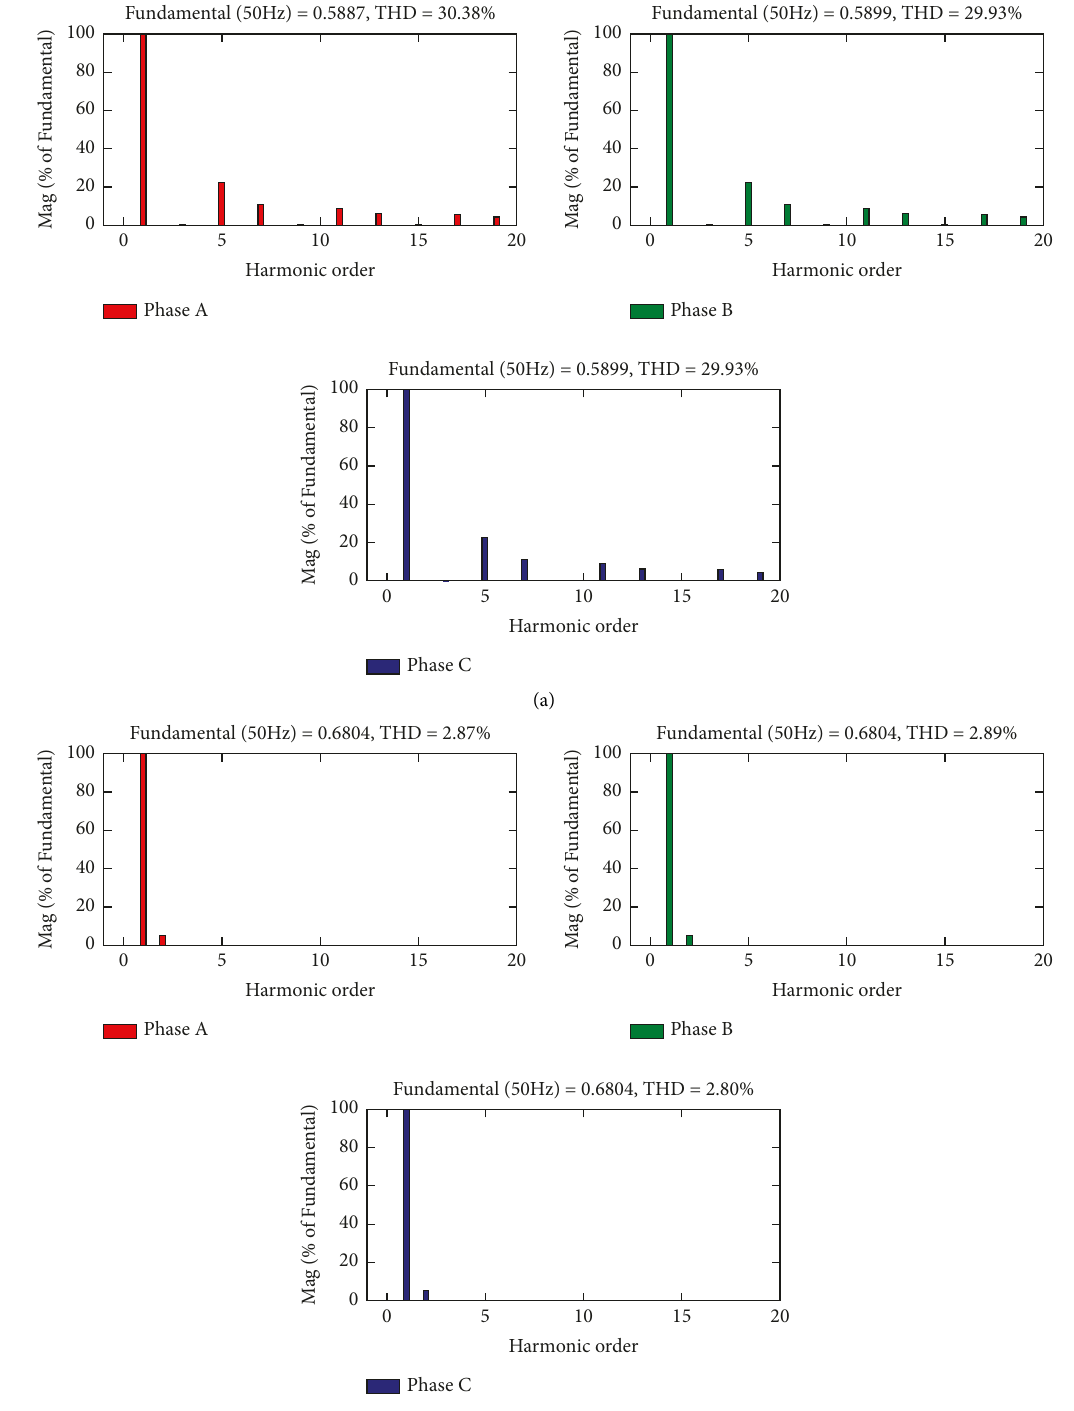
Figure 16: Source current THD spectrum before and after the interconnection of the proposed MMPIFC boost converter fed PV-SHAPF. (a) THD of source current before compensation. (b) THD of source current after